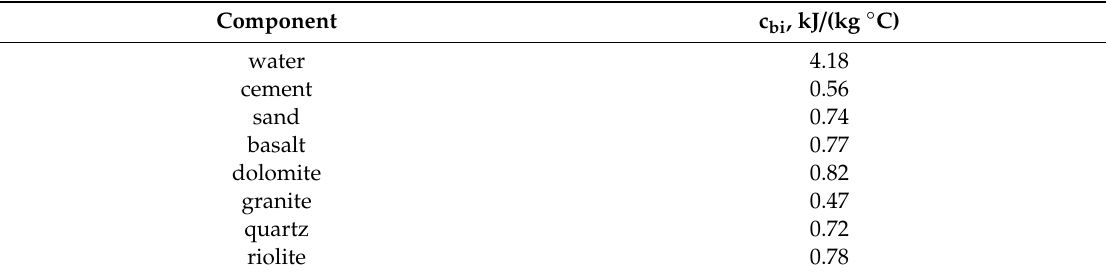
Table 1. Specific heat c bi for concrete components, on the basis of [19].